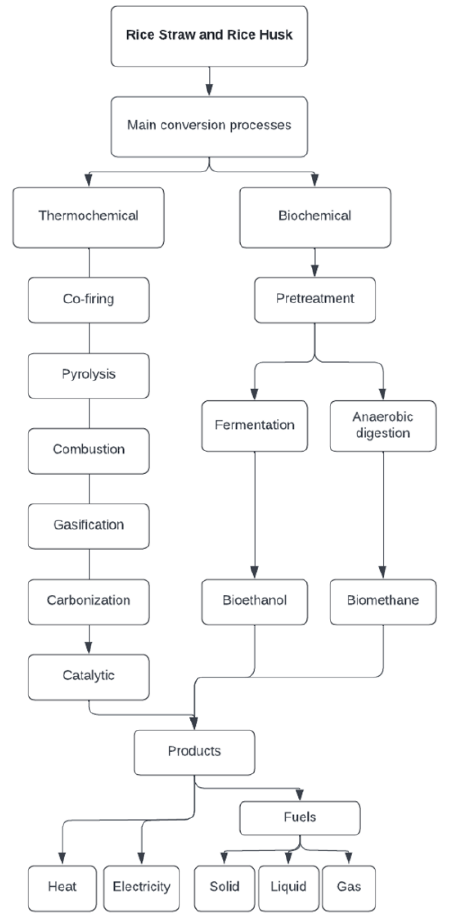
Figure A2. Energy generation technologies.